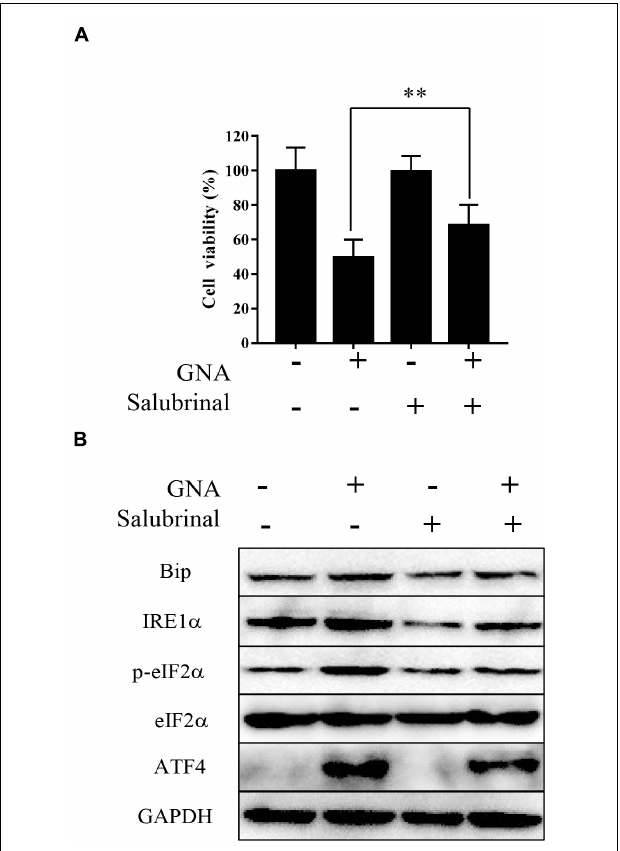
FIGURE 4 | GNA activated ER stress-associated apoptosis by targeting eIF2 α . HCT116 cells were treated with GNA (1 µ M) after pretreatment with salubrinal (10 µ M). (A) After GNA treatment 24 h, MTT assay was used to analyse cell viability. MTT solution was added to the well and incubated for 4 h at 37 ◦ C. The precipitate was dissolved in DMSO, and the absorbance was measured at 570 nm. (B) After GNA treatment 6 h, The expression of